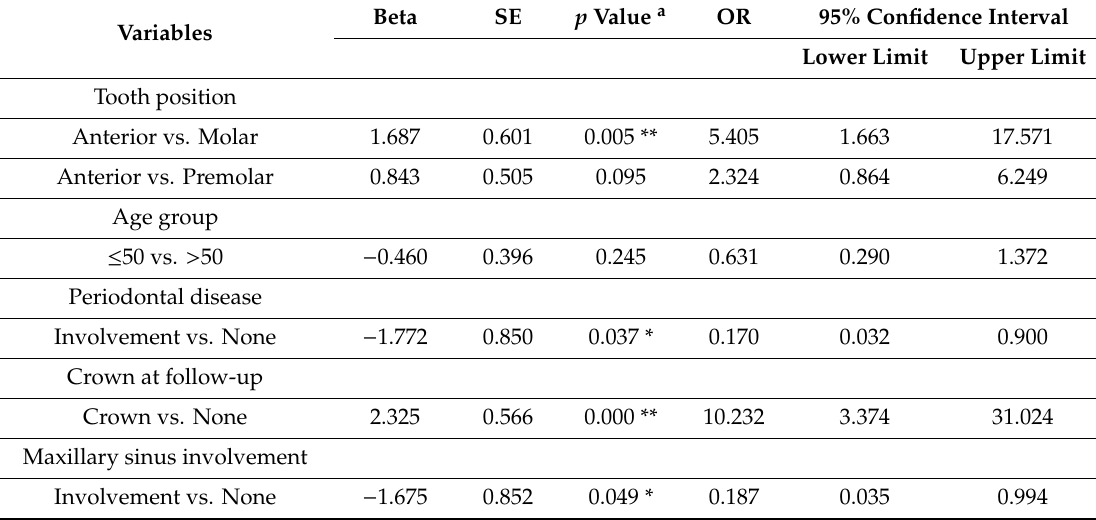
Table 3. Results of logistic regression model.